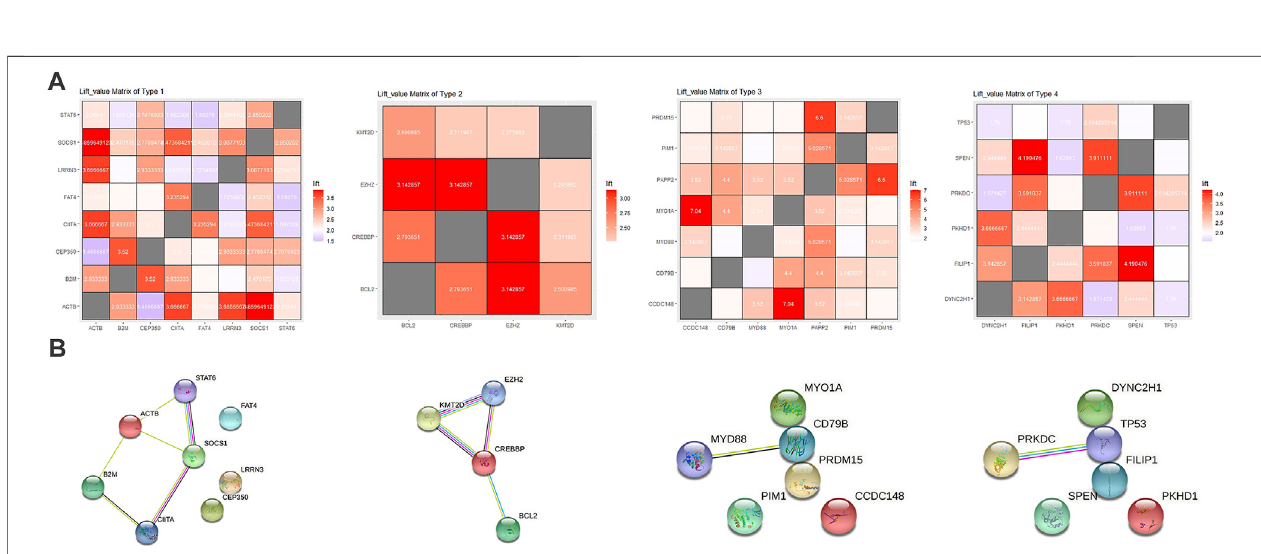
FIGURE 2 | (A) Histogram of frequent exon mutant genes in 92 patients. (B) From left to right: clusters 1 – 4 obtained by K-means clustering and their major mutations, and colors of charts represent the percentage of patients with a certain gene mutation in cluster. (C) Visualization of 300 rules with Gephi (Fruchterman Reingold layout). The shade depends on the lift value, and label size is proportional to the in-degree, the number of rules the consequent participates in.